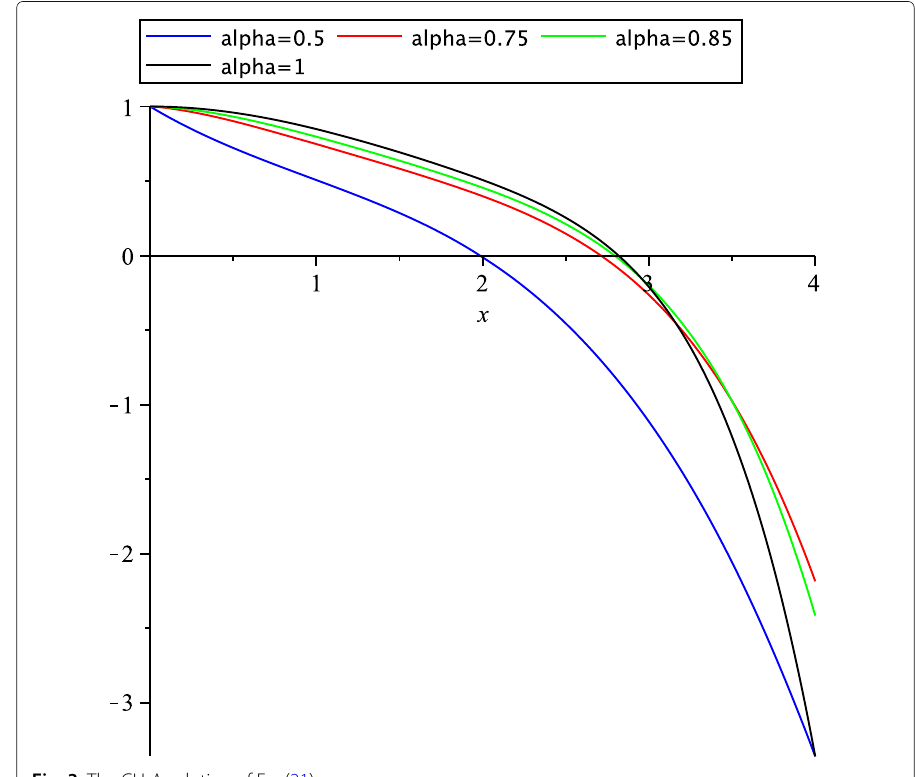
Fig. 3 The CH-A solution of Eq.